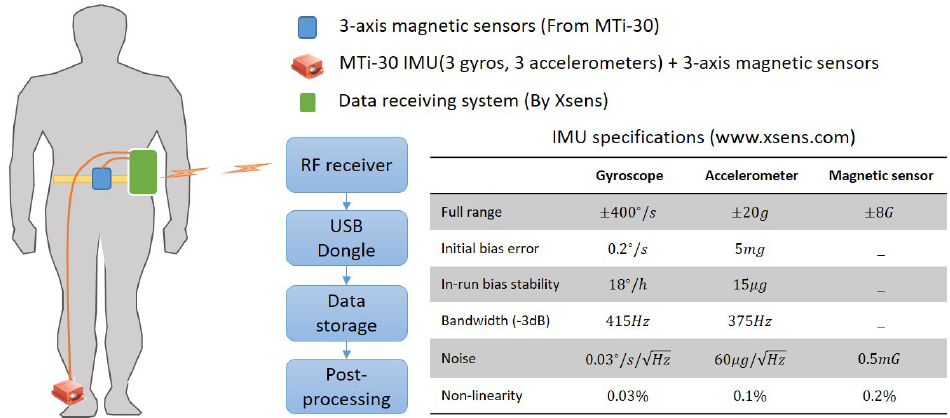
Figure 6. Measurement systems for indoor/outdoor